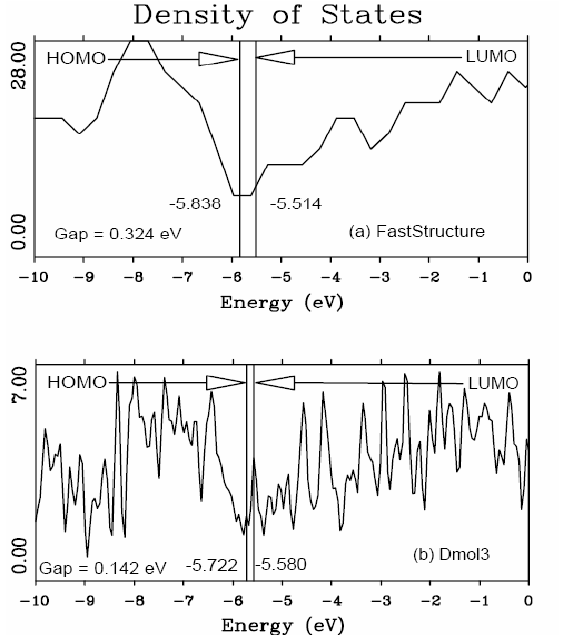
and DM OL 3, curve ( b ). HOMOs, LUMOs and gaps are